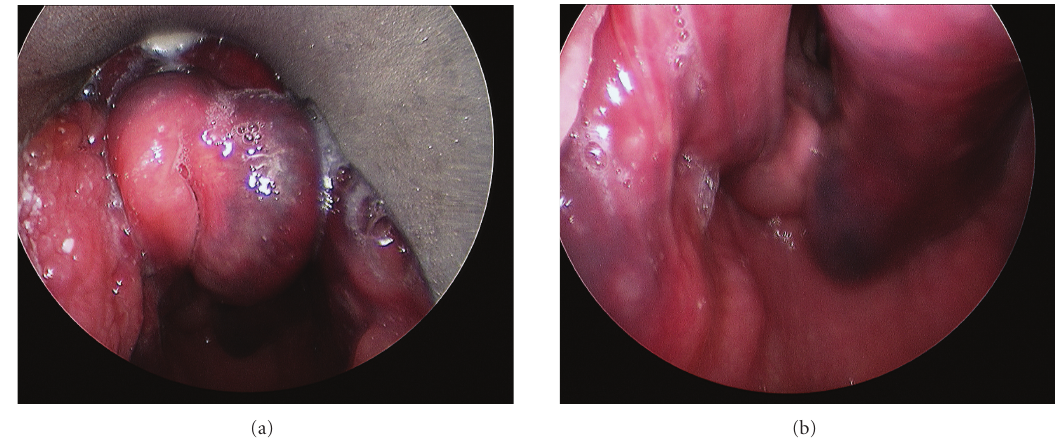
Figure 2: Direct laryngoscopy. (a) Edematous and ecchymotic epiglottis consistent with hematoma as seen on direct laryngoscopy. (b) Extension of the epiglottic hematoma to the right aryepiglottic fold and